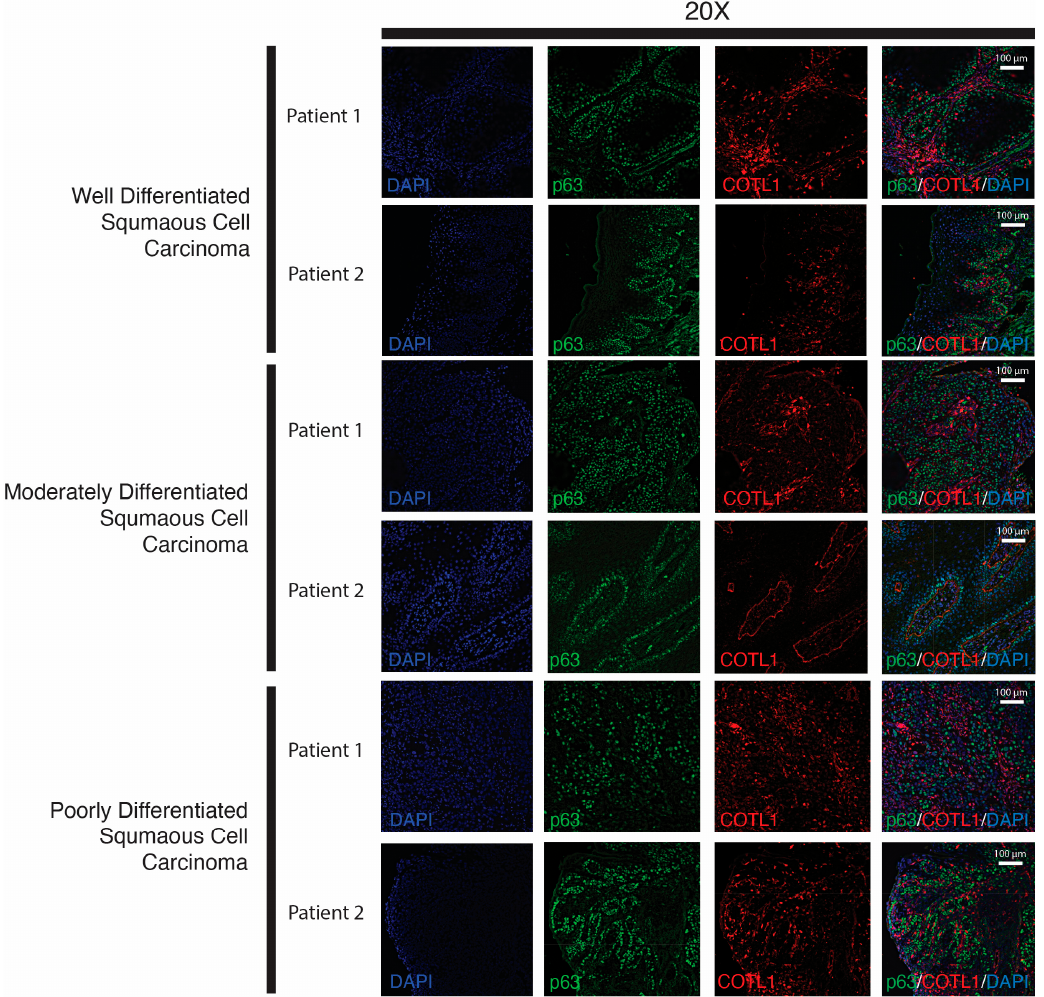
Figure 10. Co-immunofluorescence of p63 and COTL1 in human OSCC tissue. Two independent samples of well-differentiated, moderately differentiated, and poorly differentiated human OSCC tissues were co-stained for p63 (green) and COTL1 (red), and imaged at 20 × magnification. DAPI (blue) was used as a nuclear stain.